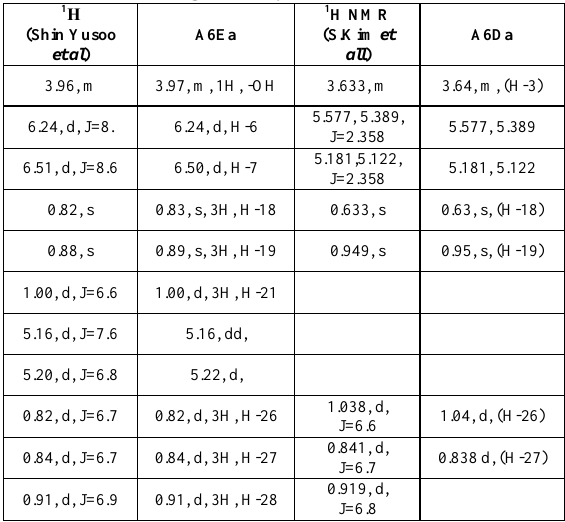
Table 1. l H NMR spectral data of ergosterol ( 3 ) and